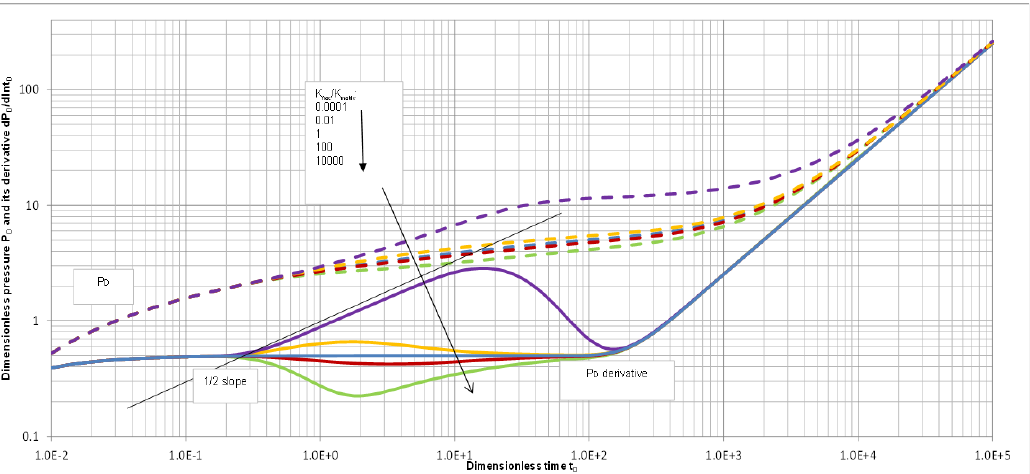
Figure 9. Pressure and its derivative behaviors of the well with respect to different permeability ratios of natural fracture to formation, 𝑊 𝐷 = 50 , 𝐻 𝐷 = 50 , 𝑤 𝑓𝐷 = 0.01 , 2𝐿 𝑓𝐷 = 10 , and 𝑋 𝑣𝐷 = 2 .